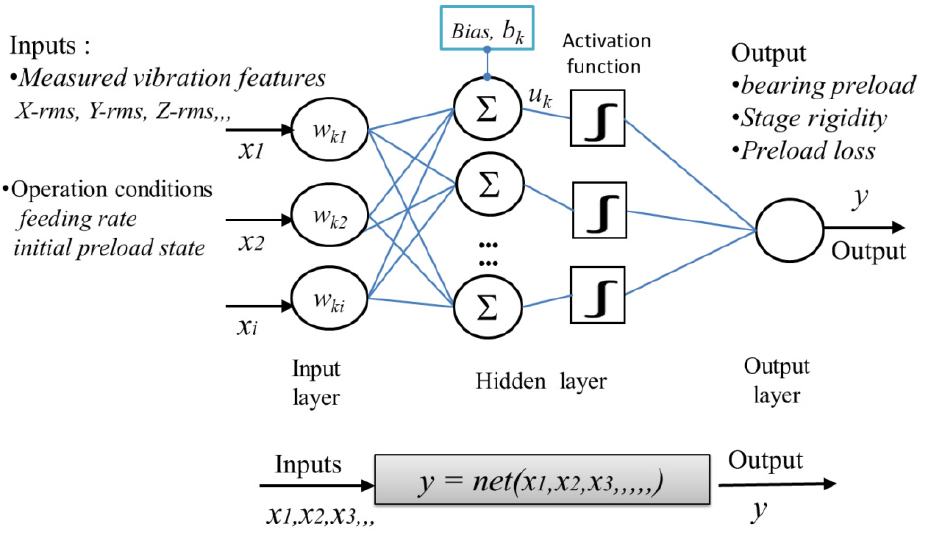
Figure 14. Architecture of neural network model.